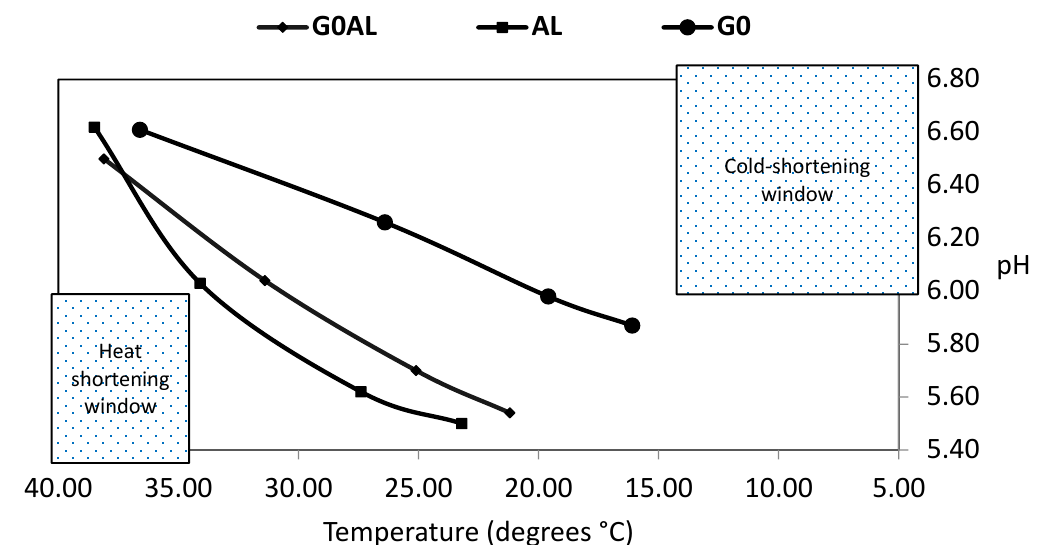
Figure 4. The post-mortem pH/temperature “window” in Longissimus thoracis from suckler bulls slaughtered after: 199 days at pasture (G0); 98 days at pasture followed by 101 days indoors and offered concentrates (G0AL); and 199 days indoors and offered concentrates (AL). Mean values per group.